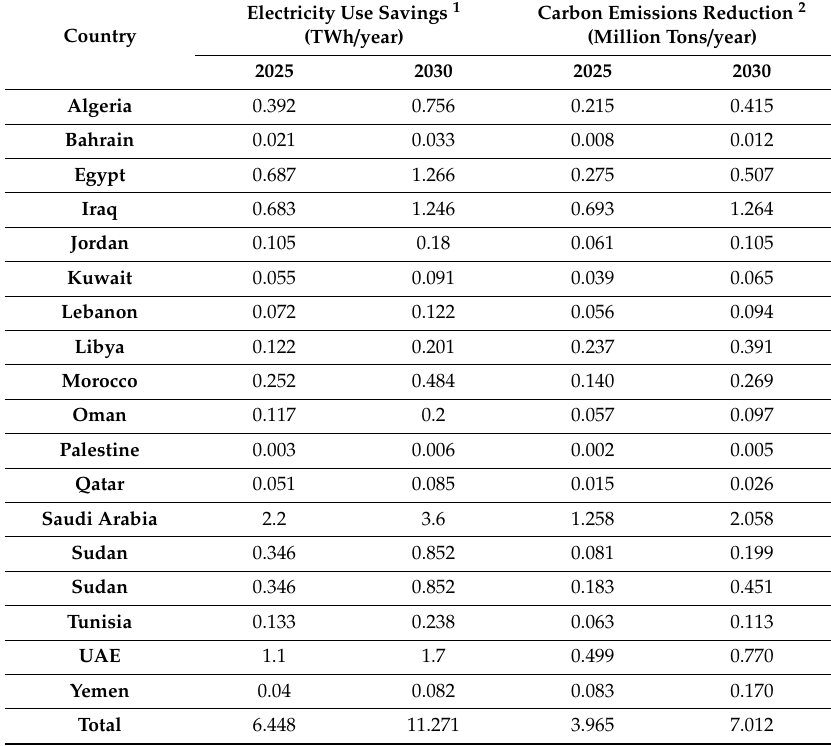
Table 15. PotentialannualbenefitsattributedtoimprovedMEPsforroomair-conditionersintheArabregion.